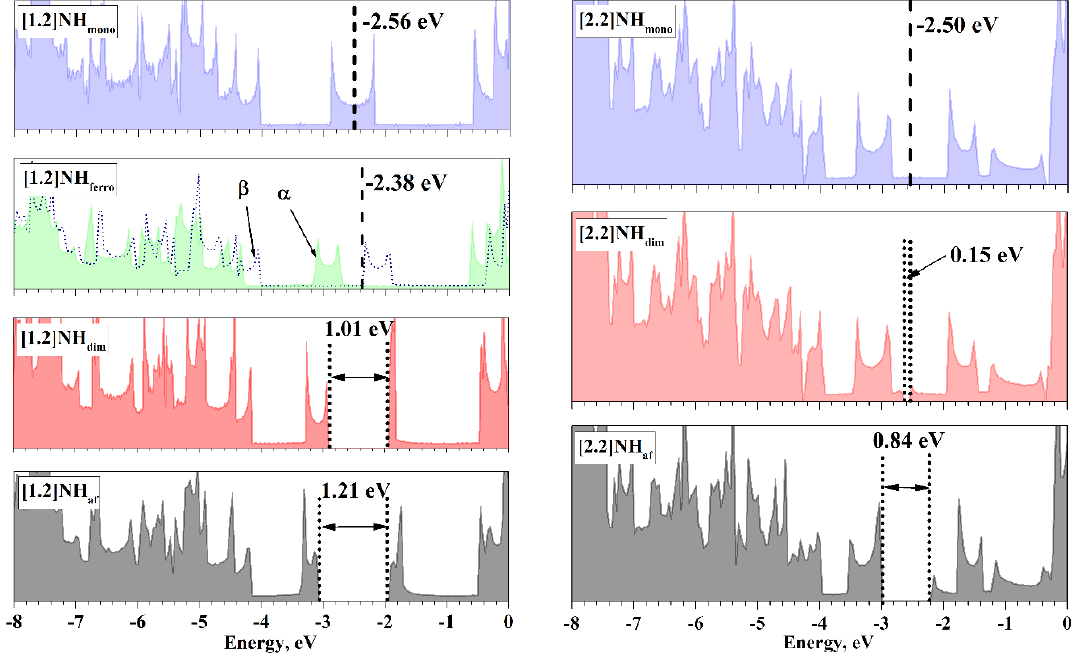
Figure 4. DOS of the NH at the point close to the energy minimum. For the [1.2]helicene, this is L 41 6 and L 41 3 in the case of the monomeric and dimeric states, respectively. For the [2.2]helicene, this is L 56 25 and L 28 25 in the case of the monomeric and dimeric states, respectively. Fermi energies are shown by dashed lines. The top of the valence band, TVB, and the bottom of the conduction band, BCB, are indicated by dotted lines. α and β indicate the corresponding spin DOS in the case of the [1.2]NH ferro .